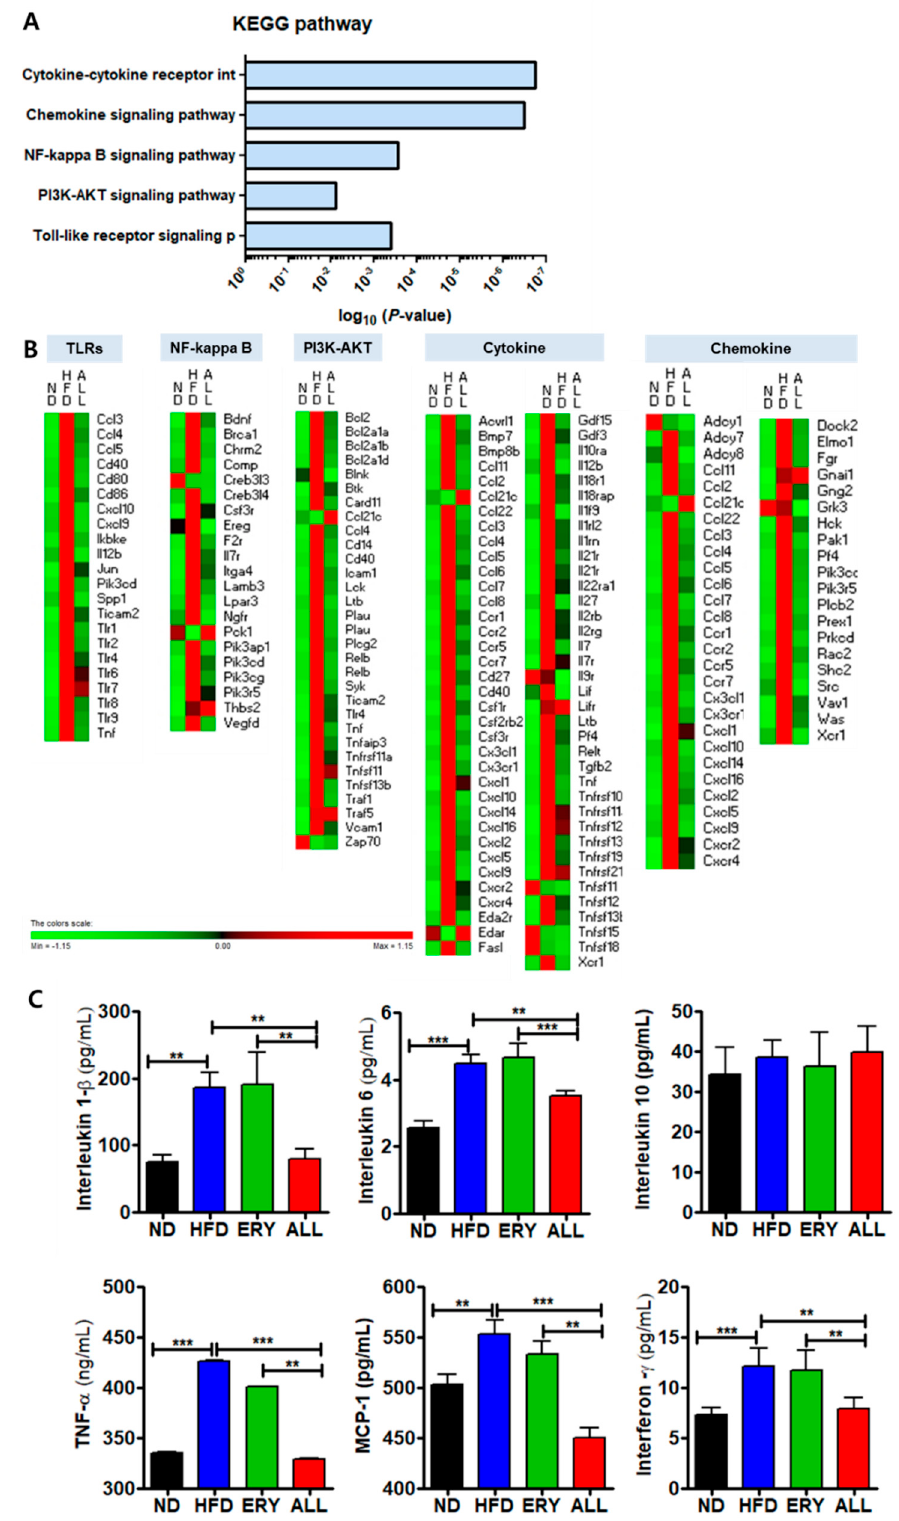
Figure 4. Gene transcription patterns related to inflammation in hepatic tissue. ( A ) Significant KEGG pathways. ( B ) The heatmap shows genes associated with the Toll-like receptor, NF-kappaB, PI3K-AKT, cytokine, and chemokine pathways. ( C ) Plasma inflammatory cytokine levels. Symbols in red were upregulated, whereas those in green were downregulated. Significant differences among the experiment groups are indicated; * p < 0.05, ** p < 0.01, *** p < 0.001; ND, normal diet (AIN-76); HFD, high-fat diet (AIN-76, 20% fat, 1% cholesterol); ERY (HFD + 5% Erythritol); and ALL, (HFD + 5% D- allulose).